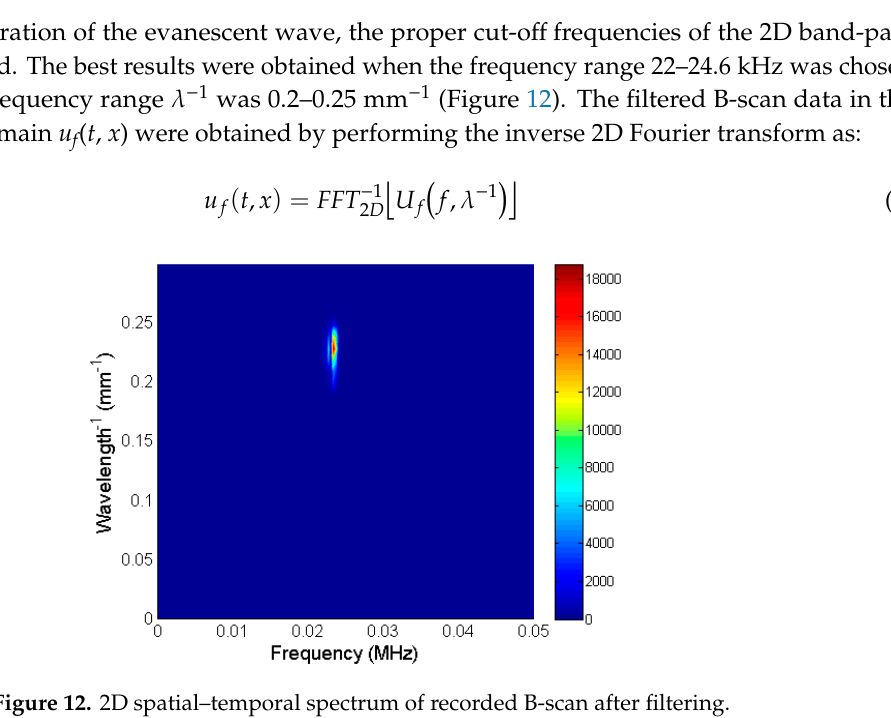
Figure 11. 2D spatial–temporal spectrum of recorded B-scan before filtering.